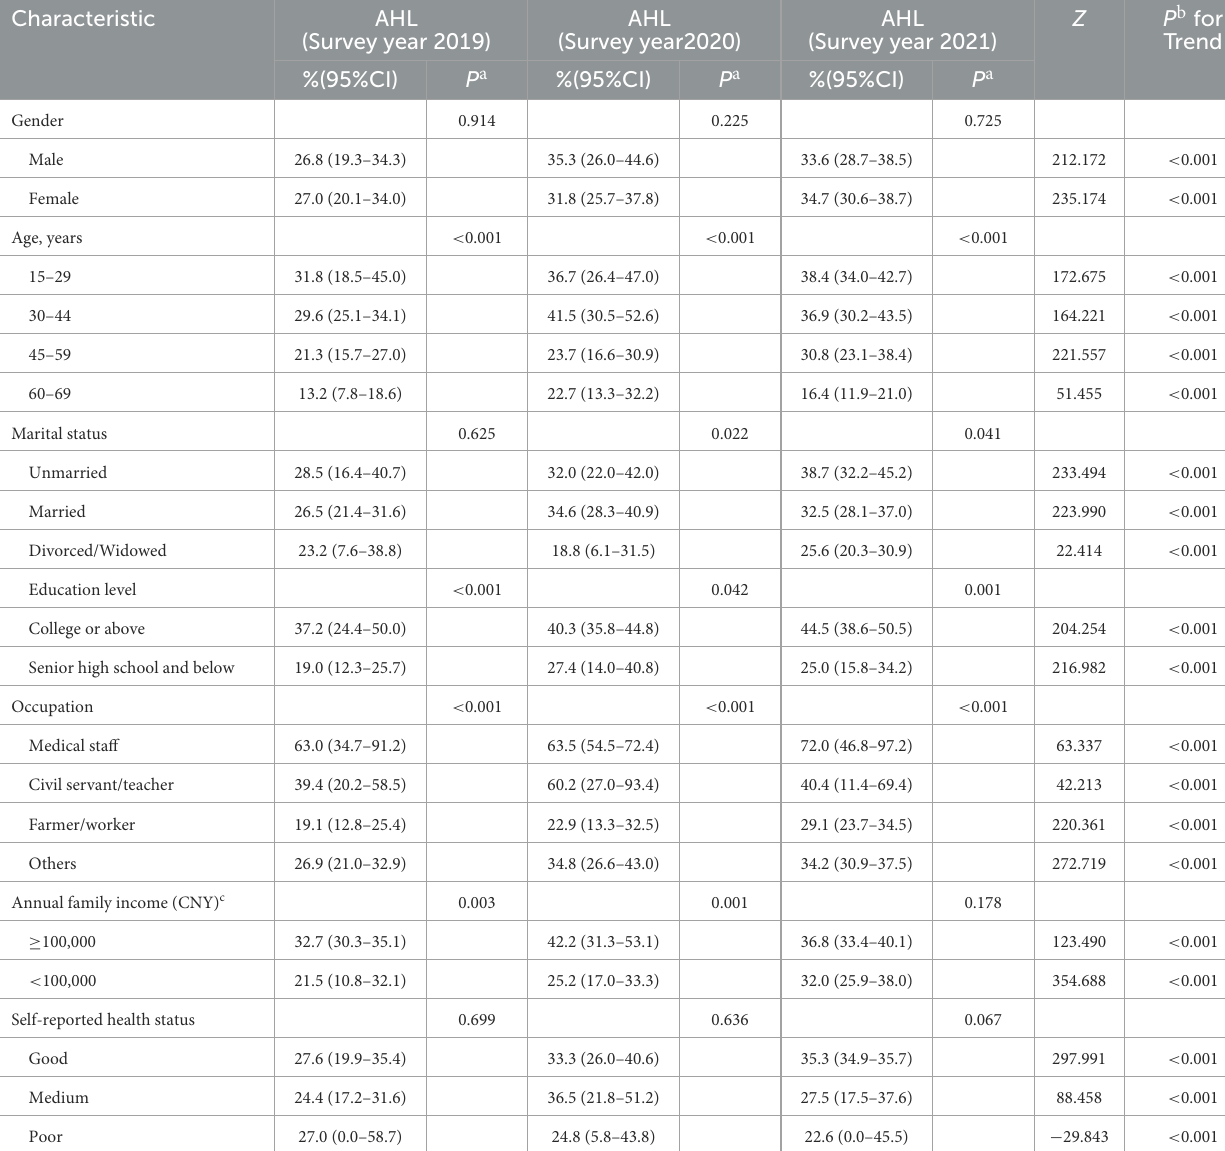
TABLE 2 Factors related to adequate health literacy (AHL) over time—results of bivariate analyses and trend analysis (weighted).